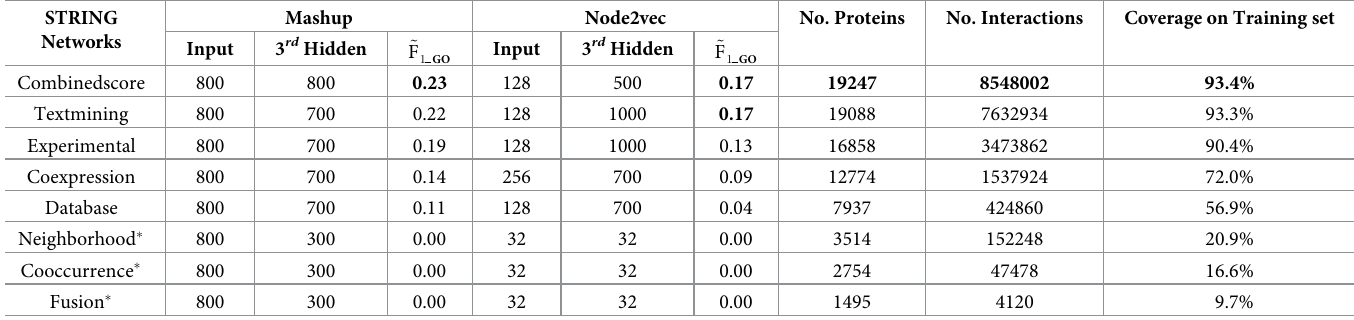
Table 1. The optimal dimensions of raw network embedding representations and the corresponding 3 rd hidden layer outputs (a.k.a. the STRING2GO-learnt func- tional representations) with their corresponding predictive power for biological process terms prediction, and the main characteristics of different STRING